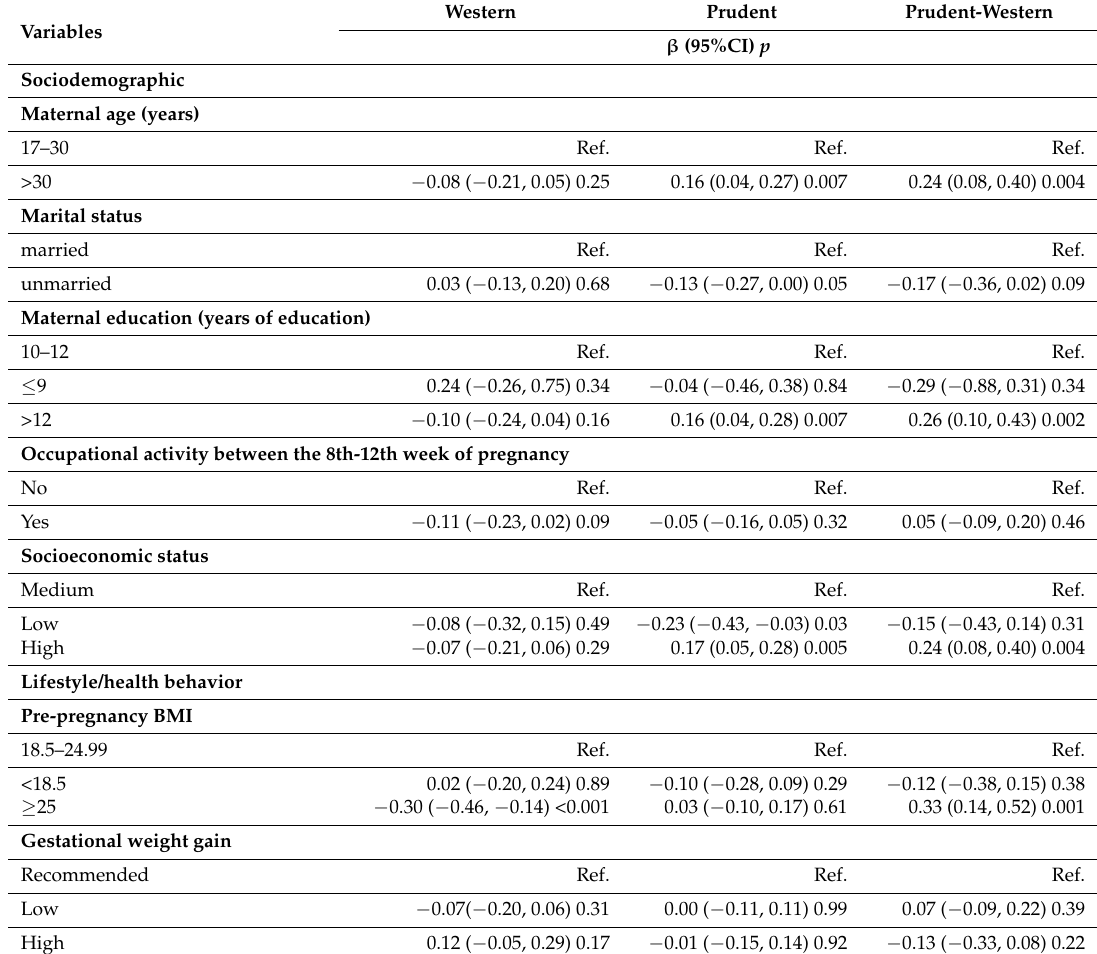
Table 3. Sociodemographic, lifestyle, environmental, and pregnancy-related determinants of dietary pattern scores during pregnancy—multivariate linear regression model (N = 958)